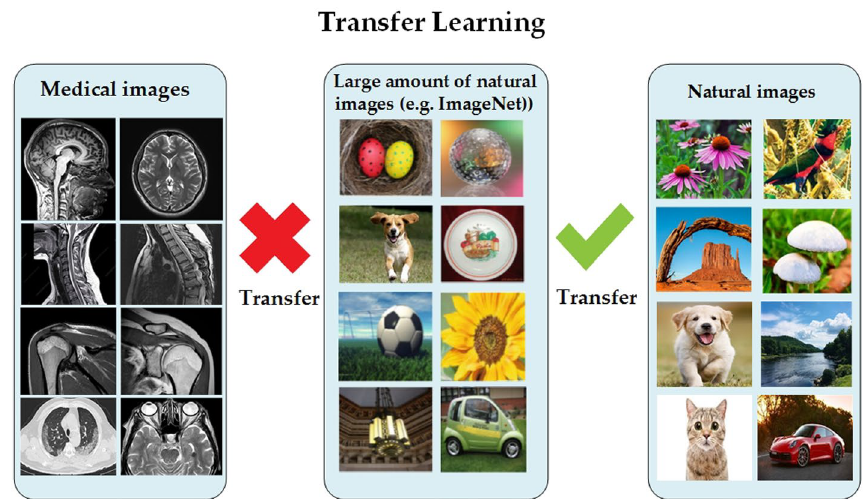
Fig. 8 Comparison between TL from ImageNet to nature images and medical images